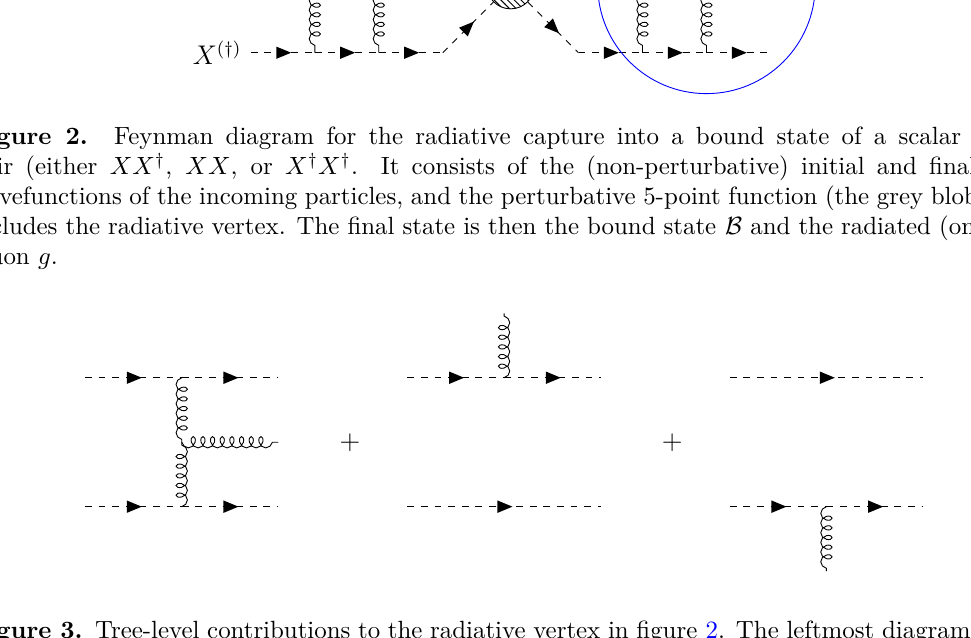
Figure 3. Tree-level contributions to the radiative vertex in figure 2. The leftmost diagram shows the radiation from the gluon propagator, allowed by the non-Abelian nature of QCD. The other two contributions come directly from the emission from an external